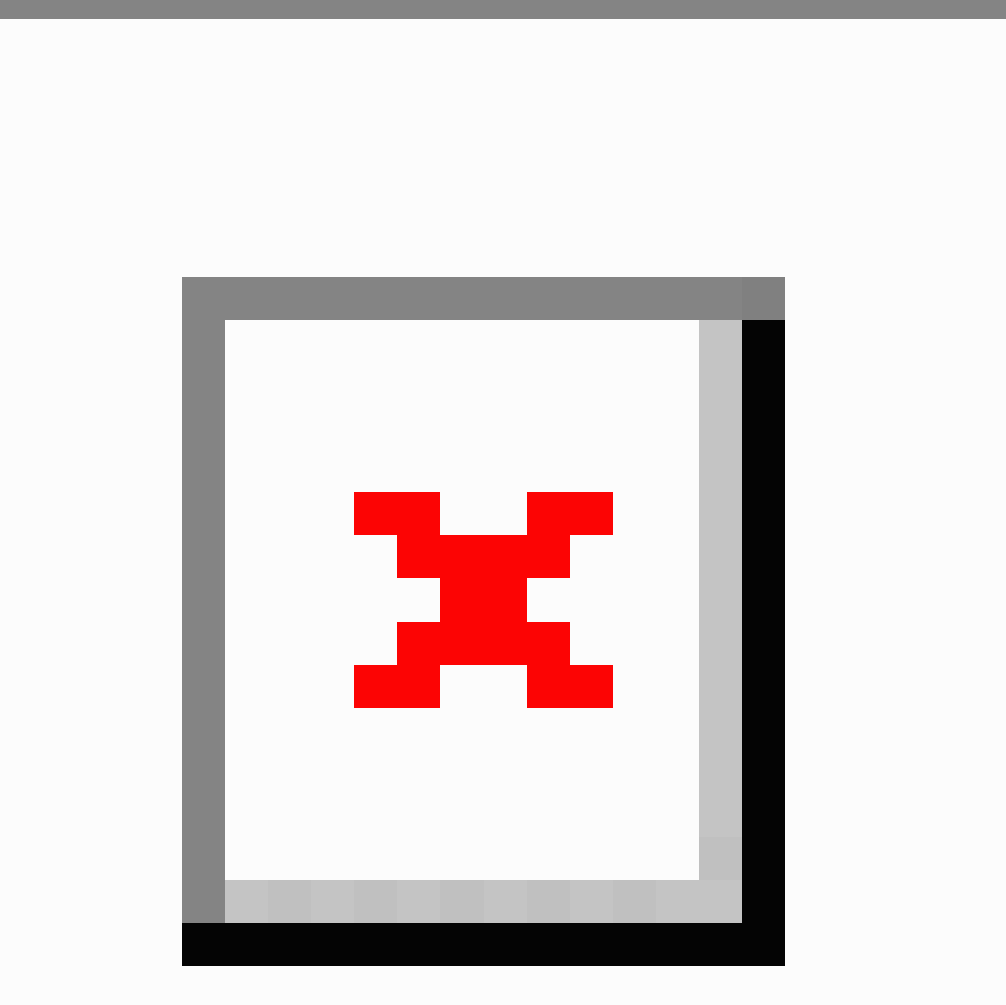
Figure 4. Doximity connects colleagues from around the United States and allows for secure